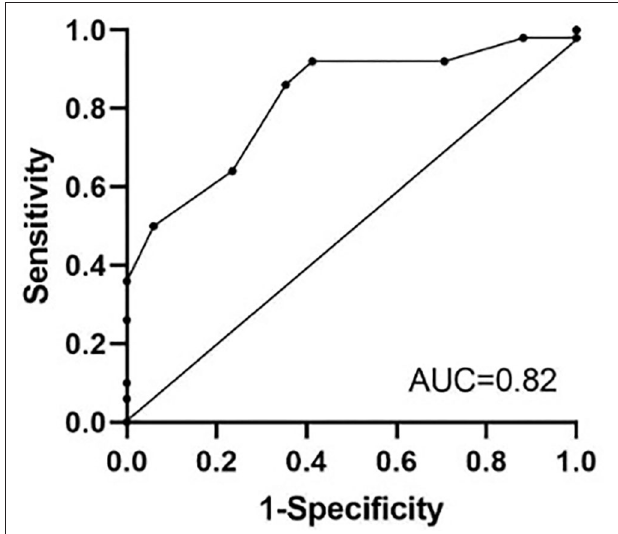
FIGURE 2 | Receiver operating characteristics (ROC) curve for the colic assessment score to predict survival in the retrospective study. A cutoff value of 7 for the colic assessment score maximized sensitivity (86%) and specificity (64%) to predict survival in horses presenting for colic. AUC, area under the